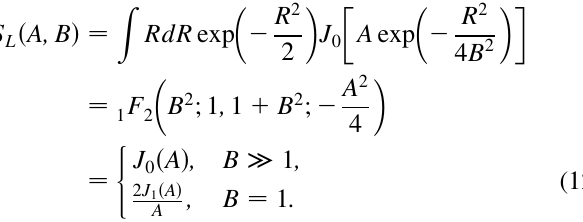
mc 2 (cid:5) 40 keV for (cid:9) L